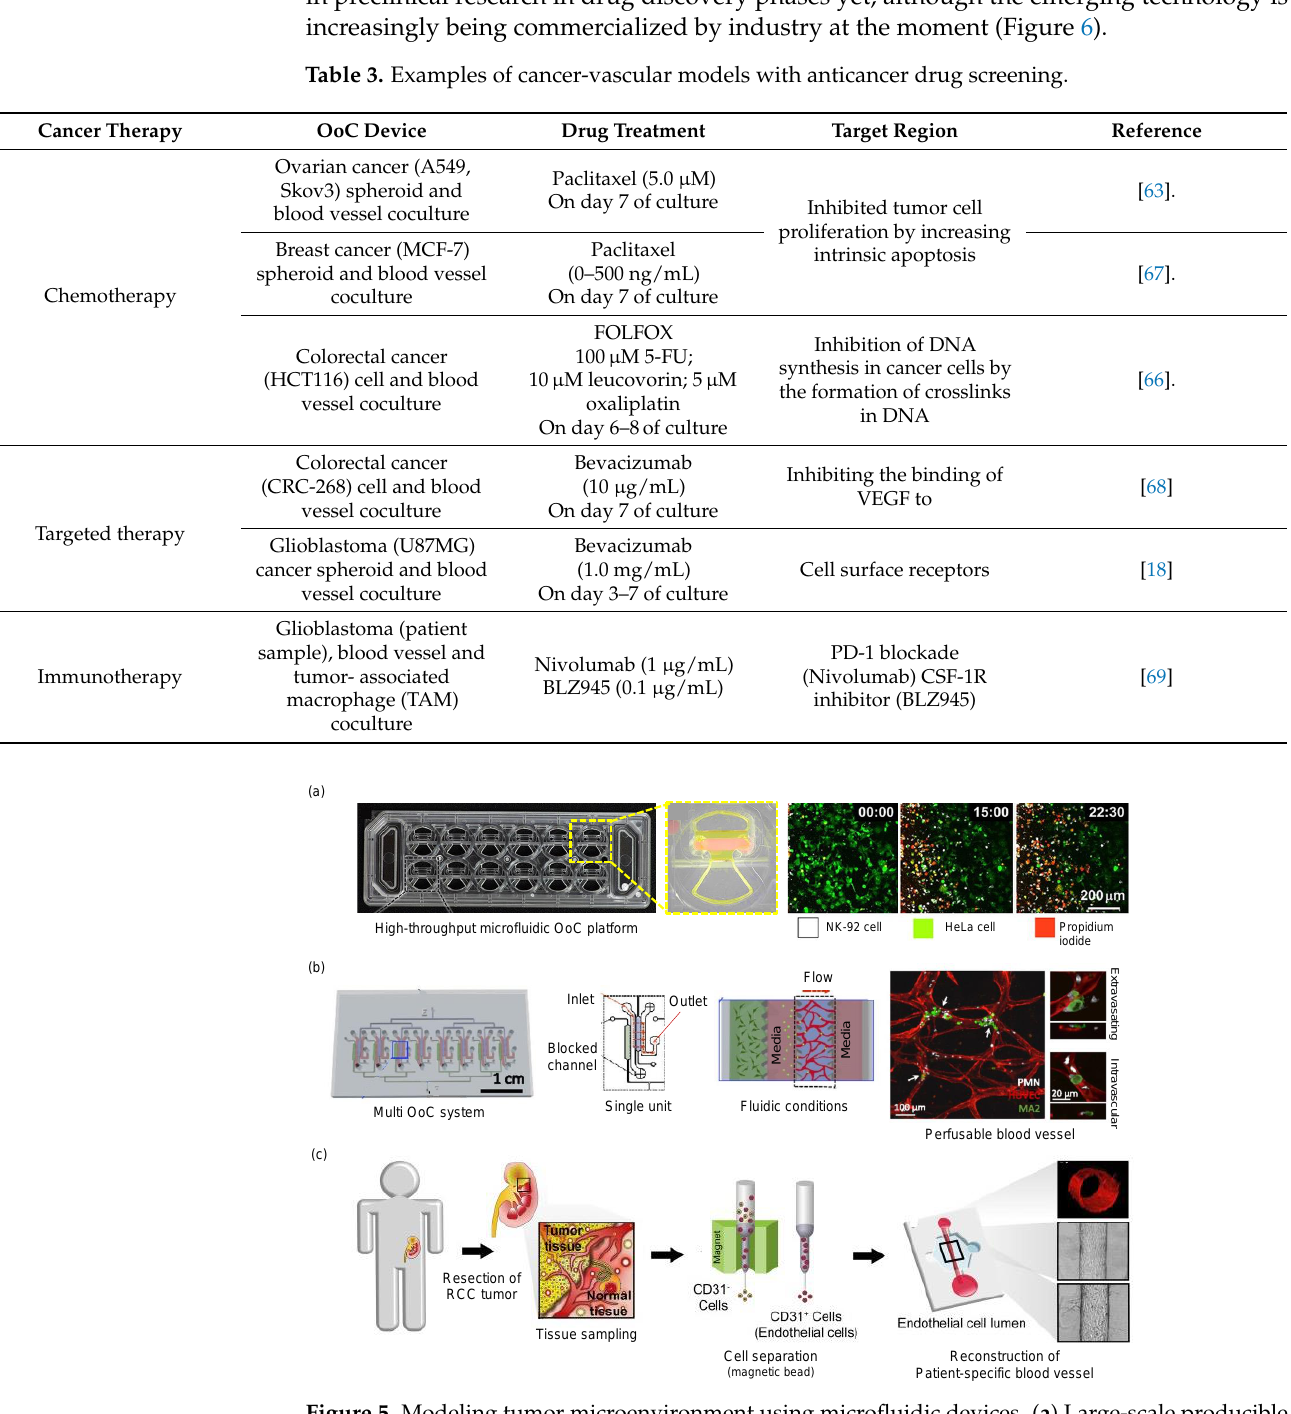
Figure 5. Modeling tumor microenvironment using microfluidic devices. ( a ) Large-scale producible microfluidic chip to utilize 3D cytotoxicity assay. Figure reproduced from Park et al., 2019 [21]. ( b ) Multiplexed microvascular network to quantify the dynamics of arrest and extravasation of tumor cells and inflammation-stimulated neutrophils in the microfluidics chip. Figure reproduced from Chen et al., 2018 [61]. ( c ) Isolation endothelial cells from cancer patient samples and reconstruction of patient-specific tumor vasculature models in the microfluidic device. Figure reproduced from Jimenez-Torres et al., 2019 [62].